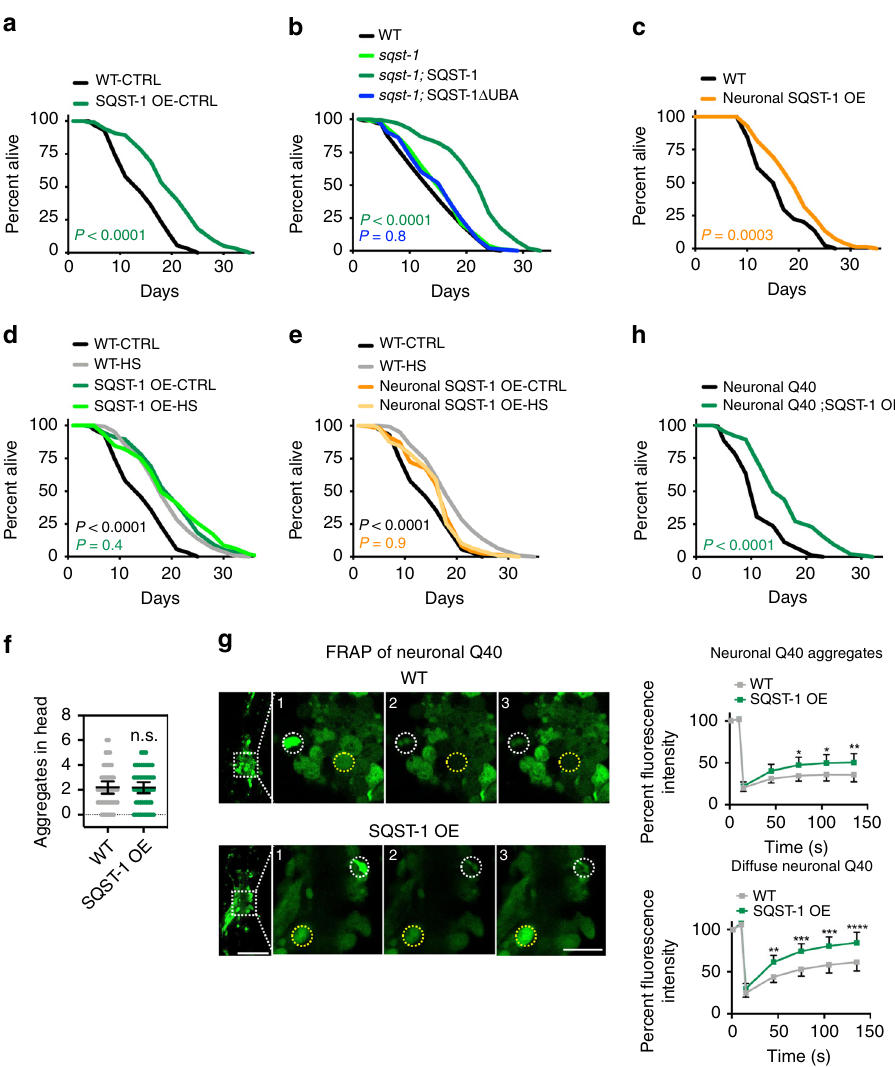
Fig. 3 SQST-1 overexpression extends C. elegans lifespan and improves proteostasis. a Lifespan analysis of WT (N2) ( N = 58 animals) and SQST-1 OE ( sqst-1p::sqst-1::gfp (1)) ( N = 88 animals) animals at 20 °C: P -value by log-rank test. b Lifespan analysis of WT (N2) ( N = 92 animals), sqst-1(syb764) ( N = 88 animals), and sqst-1(syb764) animals expressing either sqst-1p::sqst-1 + rol-6 ( sqst-1; SQST-1) ( N = 124 animals) or sqst-1p::sqst-1 Δ UBA + rol-6 ( sqst-1; SQST-1 Δ UBA) ( N = 107 animals) at 20 °C. P -values by log-rank test. c Lifespan analysis of WT (N2) ( N = 85 animals) and neuronal SQST-1 OE ( rgef-1p:: sqst-1::gfp (1)) ( N = 85 animals) animals at 20 °C. P -value by log-rank test. d Lifespan analysis of WT (N2) and SQST-1 OE ( sqst-1p::sqst-1::gfp (1)) animals subjected to hormetic HS on day 1 of adulthood. WT-CTRL, N = 126; WT-HS, N = 111; SQST-1 OE-CTRL, N = 116, SQST-1 OE-HS, N = 106 animals at 20 °C. P -values by log-rank test. e Lifespan analysis of WT (N2) and neuronal SQST-1 OE ( rgef-1p::sqst-1::gfp (1)) animals subjected to hormetic HS on day 1 of adulthood. WT-CTRL, N = 126; WT-HS, N = 111; Neuronal SQST-1 OE-CTRL, N = 123, SQST-1 OE-HS, N = 120 animals at 20 °C. P -values by log-rank test. a – e See Supplementary Data 2 and Table 3 for experimental repeats. f Quanti fi cation of neuronal PolyQ aggregates (rgef-1p::Q40::yfp) on day 5 of adulthood from three independent experiments in WT ( N = 31 animals) and SQST-1 OE animals ( sqst-1p::sqst-1 + rol-6 ) ( N = 30 animals). Error bars indicate 95% CI. ns: P > 0.05 by t -test. g Fluorescence images and FRAP measurements of the aggregated (white dashed circles) and diffuse (yellow dashed circles) portion of neuronal PolyQ (rgef-1p::Q40::yfp) on day 8 of adulthood in WT and SQST-1-overexpressing animals sqst-1p::sqst-1 + rol-6 (SQST-1 OE) at 20 °C. Fluorescence signal bleached after 10 s (timepoint 2) and fl uorescence recovery was measured for 2 min. The average % of fl uorescence intensity was quanti fi ed from three independent experiments in WT, N = 32; SQST-1 OE, N = 31. Image numbers correspond to the indicated timepoints. Error bars indicate 95% CI. All measurements are P > 0.05 by two-way ANOVA with Sidak ’ s multiple comparisons test unless indicated otherwise * P < 0.05, ** P < 0.01, *** P < 0.001, **** P < 0.0001. Outline of pharyngeal bulbs in image of head region. Scale bar: 20 and 10 μ m for close-up. h Lifespan analysis of Neuronal Q40-expressing animals (rgef-1p::Q40::yfp) ( N = 39 animals) and Neuronal Q40 ; SQST-1 OE ( rgef-1p::Q40::yfp; sqst-1p:: sqst-1 + rol-6) ( N = 79 animals) at 20 °C. P -value by log-rank test. See Supplementary Table 4 for experimental repeats. Source data are provided in the Source Data fi